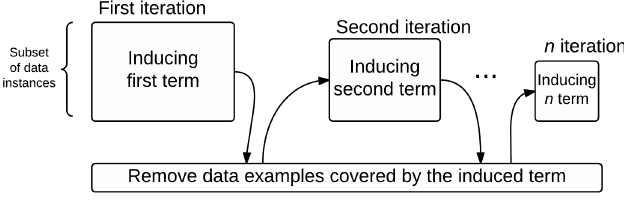
Figure 5. Iterations to specialise an inducing